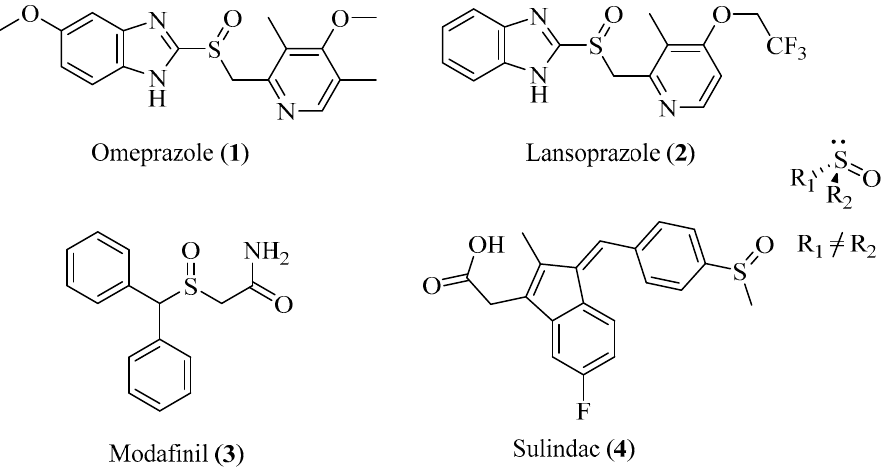
Figure 1. Chemical structures of chiral sulfoxides.